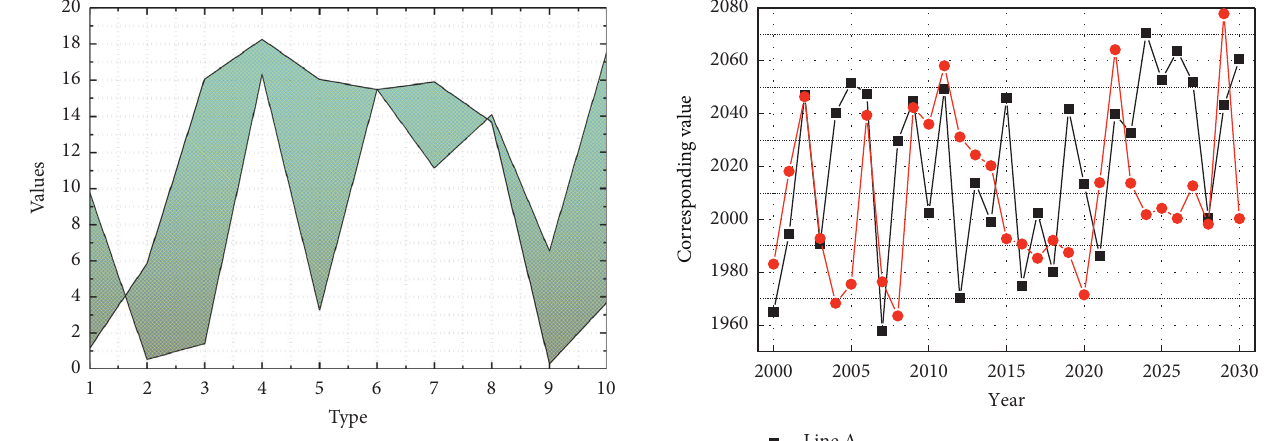
Figure 6: Comparison of CASH project investment by sector and CB industry